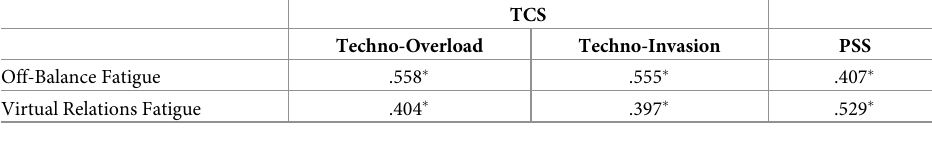
Table 4. Correlation between Online Fatigue Scale and TCS and PSS.